Question: What visual encoding does this figure use to show its data?
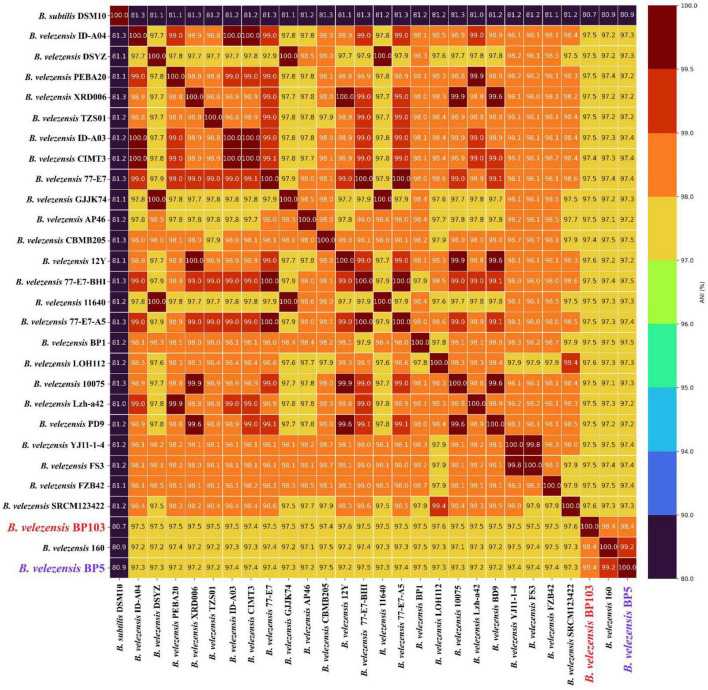
Answer: heatmap